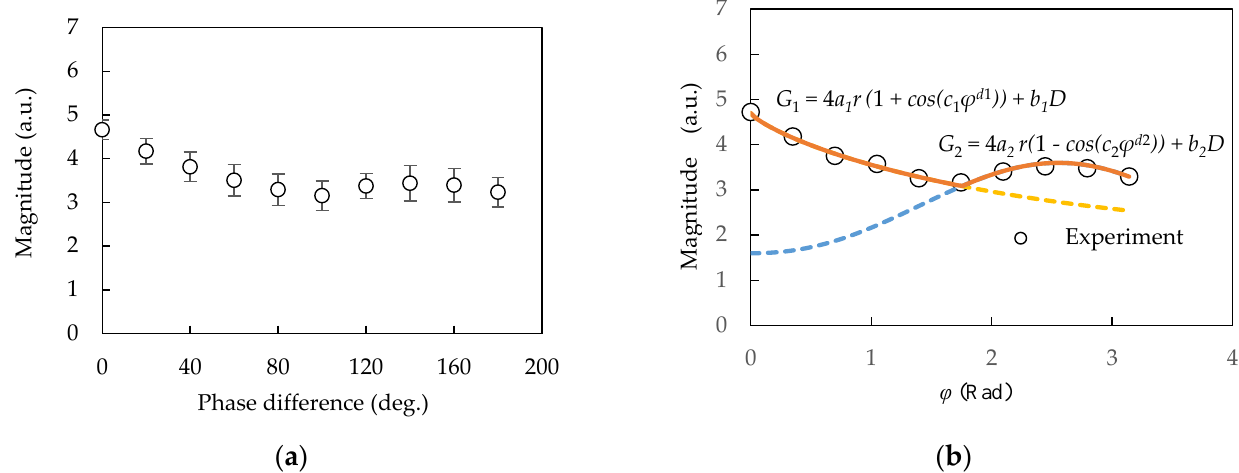
Figure 9. VHI intensity for each phase difference between two parallel moving wires and formulation verification. ( a ) VHI intensity and phase difference, ( b ) Estimation of formulated tactile Gestalts factors.